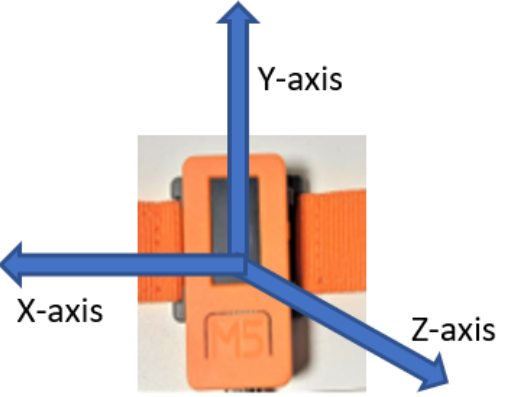
Figure 2. Axes presentation on the accelerometer device.